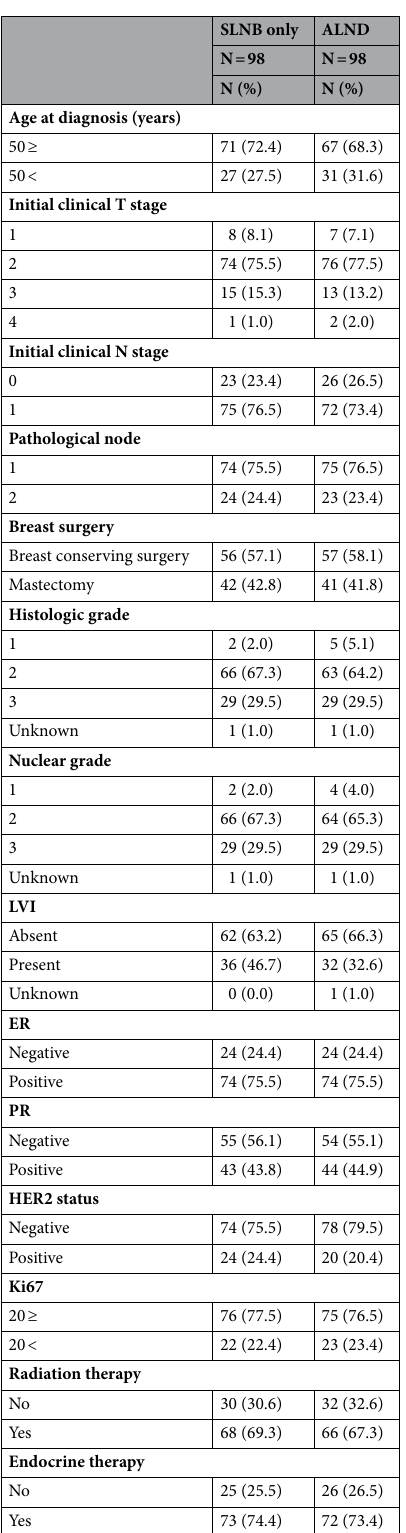
Table 3. Comparison of characteristics of patients who underwent SLNB and ALND after propensity score matching. SLNB, sentinel lymph node biopsy; ALND, axillary lymph node dissection; LVI, lymphovascular invasion; ER, estrogen receptor; PR, progesterone receptor; HER2, human epidermal growth factor receptor type